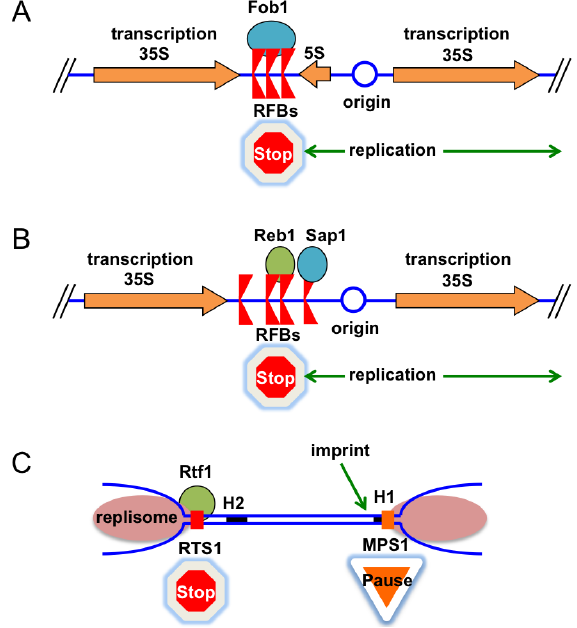
Figure 6. Replication Fork Barriers (RFBs) control DNA progression to protect genomic integrity. RFBs allow for the coordination of DNA replication with important processes on chromatin. ( A ) In budding yeast, Fob1 blocks replication fork progression in the opposing direction to 35S ribosome transcription. ( B ) In fission yeast, collisions between the transcription machinery and the replication fork are prevented by Reb1 and Sap1, which bind to the RFBs and block replisome progression near the 3' end of the 35S ribosome genes. ( C ) At the mating-type ( mat1 ) locus in fission yeast, Rtf1 bound to the RTS1 site prevents replication fork progression at the 5' side of mat1 . Only the fork in the 3' direction can progress through the region. This fork pauses at MPS1 and generates an imprint, probably a DNA strand discontinuity, which is required for a specific recombination event that allows for mating-type